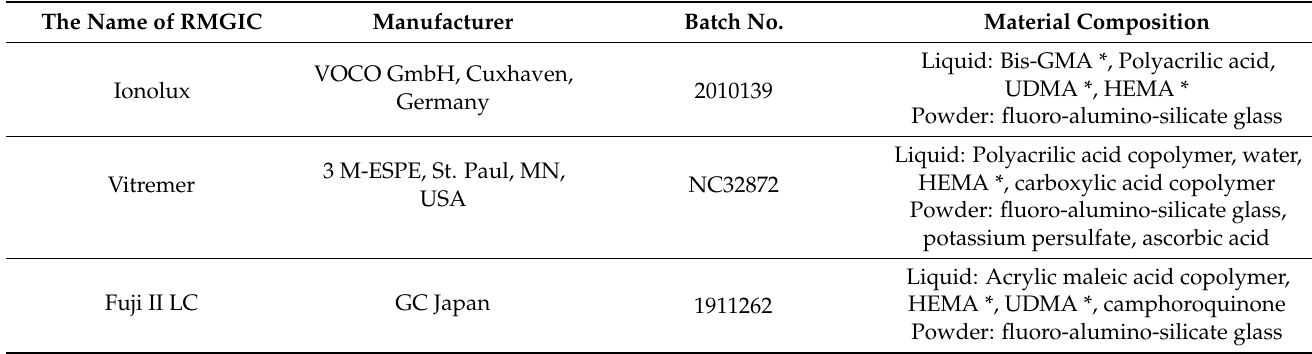
Table 1. The composition of the tested